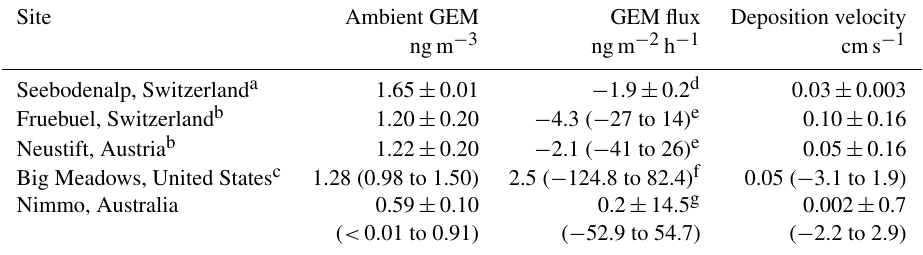
Table 3. Mean GEM, GEM flux and deposition velocity values ( ± 1 standard deviation, range in parentheses) for various studies undertaken over background THg substrate in sub-alpine grasslands during summer periods. Values taken from a Obrist et al. (2006), b Fritsche et al. (2008b) and c Converse et al. (2010). Values obtained using d modified Bowen ratio method and 30min averaging, e aerodynamic gradient and 30min averaging, f aerodynamic gradient and 20min averaging, g aerodynamic gradient and 60min